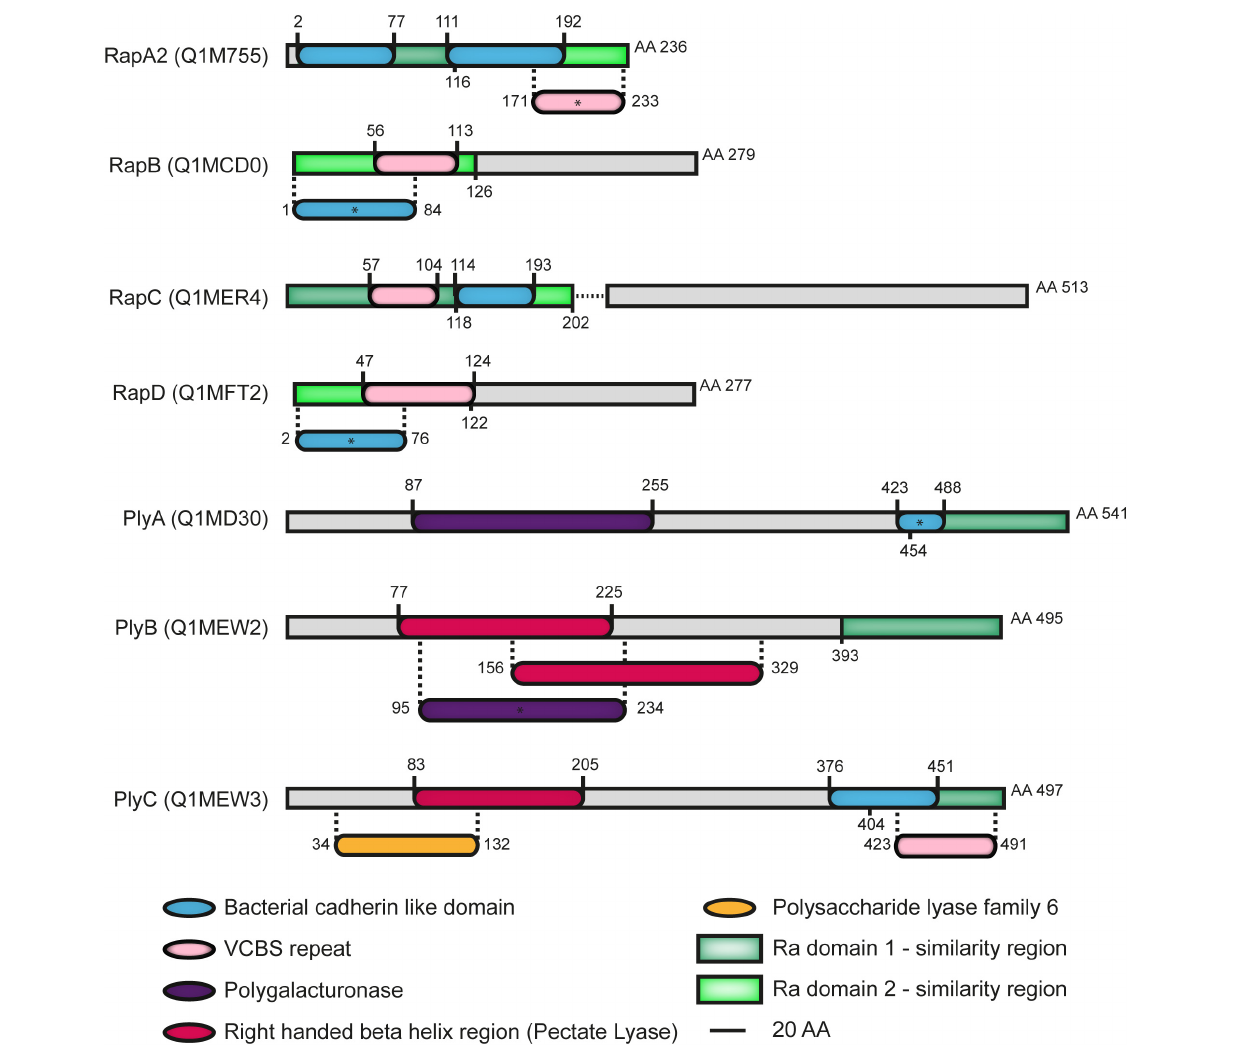
FIGURE 1 | Domains of Rap family of proteins secreted by the PrsDE system in Rhizobium leguminosarum bv. v iciae ( Rlv ) strain 3841. Ra1 and Ra2 Ra/CHDL domains from RapA2 are represented with dark and light green boxes respectively. Regions that align with those domains are depicted as the corresponding green boxes in other Raps. RapC is truncated in Rlv 3841 (aa 202), in contrast with other strains analyzed, due to a chromosomal deletion of five nucleotides which generates a stop codon shown in the scheme as a dotted line. (*) Asterisks indicate the presence of domains evidenced after setting the E -value threshold to 0.1 with the exception of RapB in which the E -value threshold was set to 0.2 (default 0.01). Ra/CHDL domains consist of about 110 residues found in several bacterial proteins with a high degree of structural similarity with the cadherin-family of eukaryotic calcium-binding proteins involved in cell-to-cell interactions. Ra domains (Ra1 and Ra2) were defined as bacterial CHDL domains (Ausmees et al., 2001; Abdian et al., 2013). CHDL domains are present in numerous bacterial and archaeal proteins and were previously proposed to confer carbohydrate-binding ability (Cao et al., 2005). Polygalacturonase, pectate lyase, and polysaccharide lyase family 6 correspond to domains found in glycanases and are related to their enzymatic activity. VCBS repeats are domains of about 100 residues found in multiple copies in large proteins of Vibrio , Colwellia , Bradyrhizobium, and Shewanella whose role is related to cell-to-cell interactions (InterPro domain